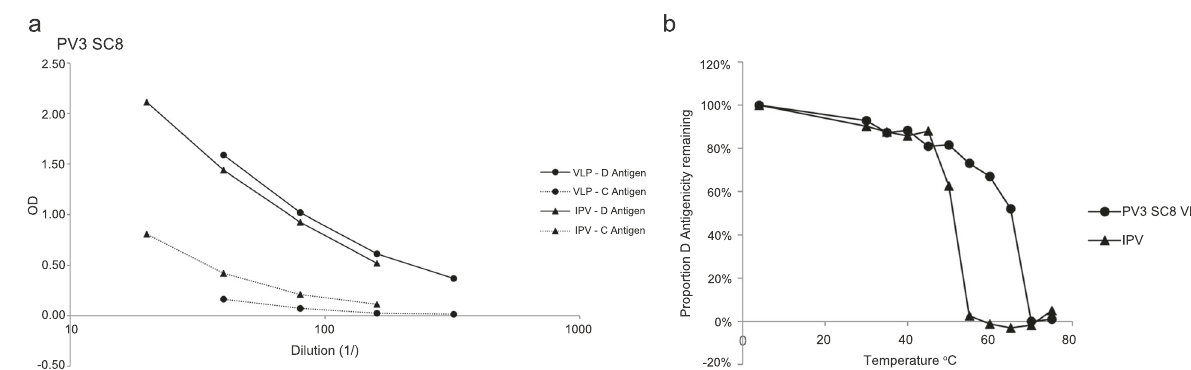
Fig. 6 Antigenicity and thermostability of the stabilised PV3 SC8 VLP. a D or C-antigen reactivity of PV3 SC8 VLP or IPV assessed by ELISA. b Reactivity of PV3 SC8 VLP and IPV aliquots to D-antigen speci fi c MAb 520 in ELISA after incubation at different temperatures for 10 minutes, normalised to corresponding aliquot incubated at 4 °C.